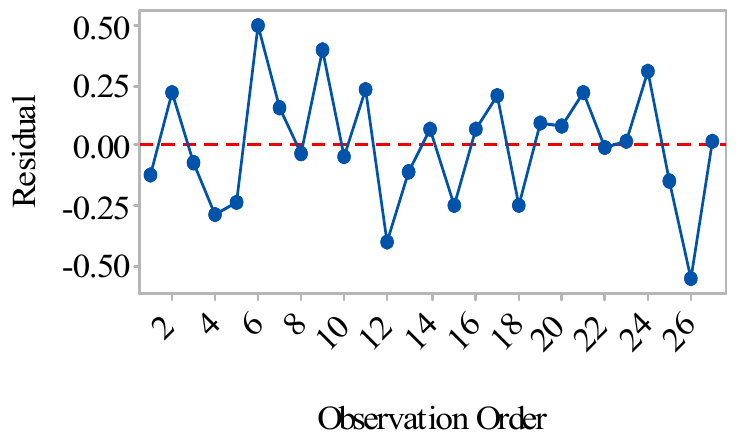
Figure 7. Residual versus observation order plot.